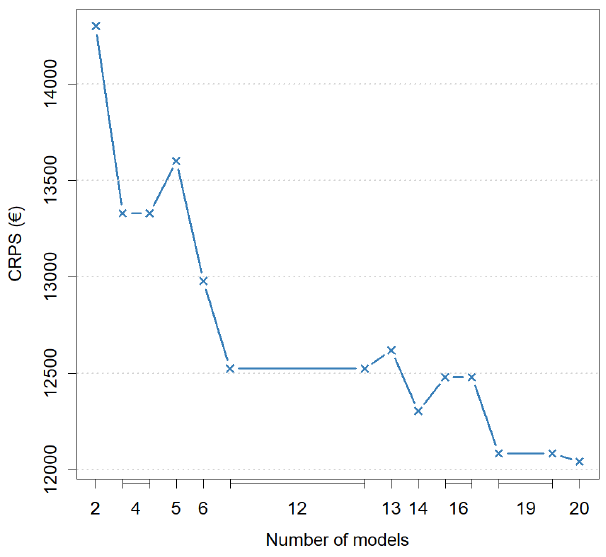
Figure 7. Continuous ranked probability score (CRPS) of the EEM- ensembles for the Caldogno application